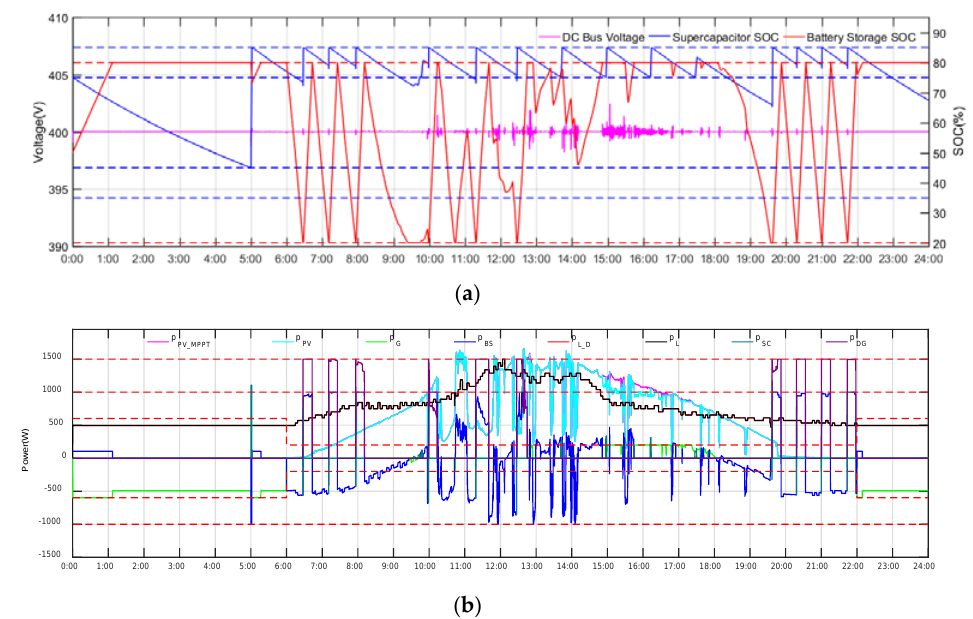
Figure 7. Curves of common DC bus voltage and state of charge (SOC) of storage ( a ) and curves of power ( b ).